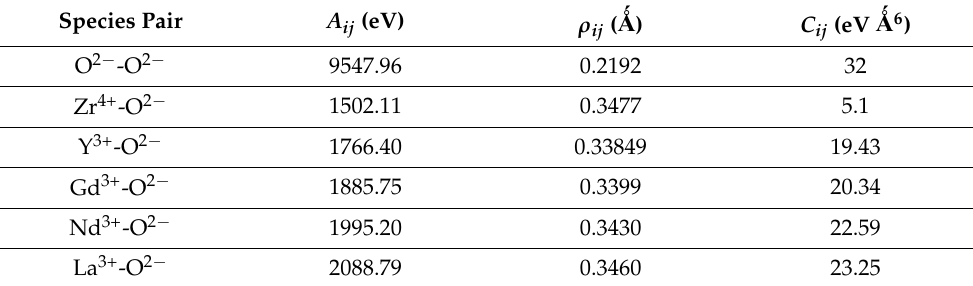
Table 1. Potential parameters of A , C , and ρ in Equation (3).